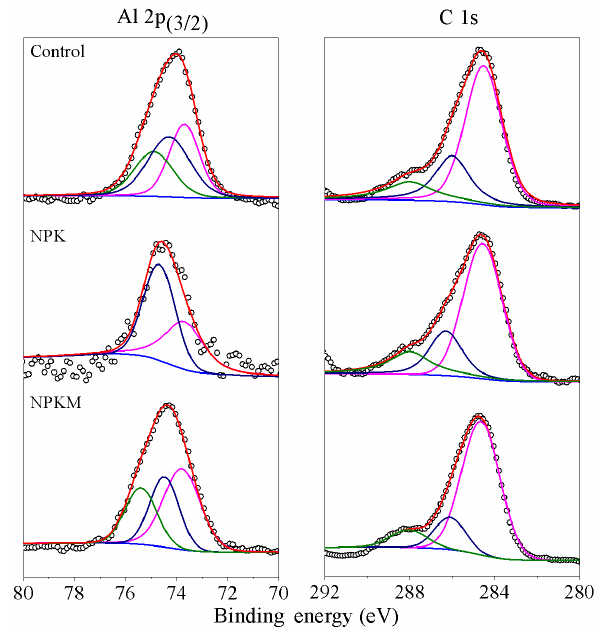
Figure 4. XPS peak-fitting (Al 2p 3 / 2 and C 1s) images recorded from soil (Ferralic Cambisol) colloids extracted under three long- term (1990–2014) fertilization treatments. Control, no fertilization; NPK, chemical nitrogen, phosphorus, and potassium fertilization; NPKM, chemical NPK plus swine manure